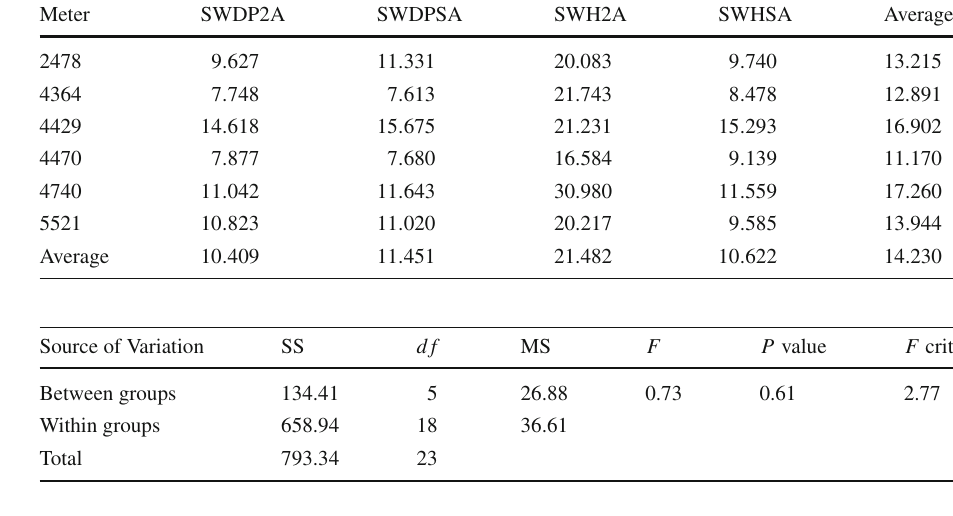
Table 4 Comparison of training window sizes (h)